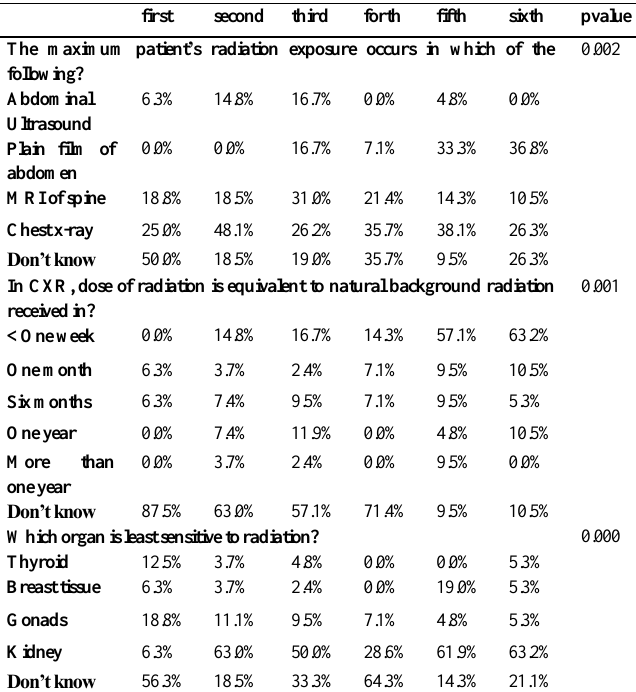
Table 3 : General awareness of radiation exposure related to diagnostic imaging examinations: